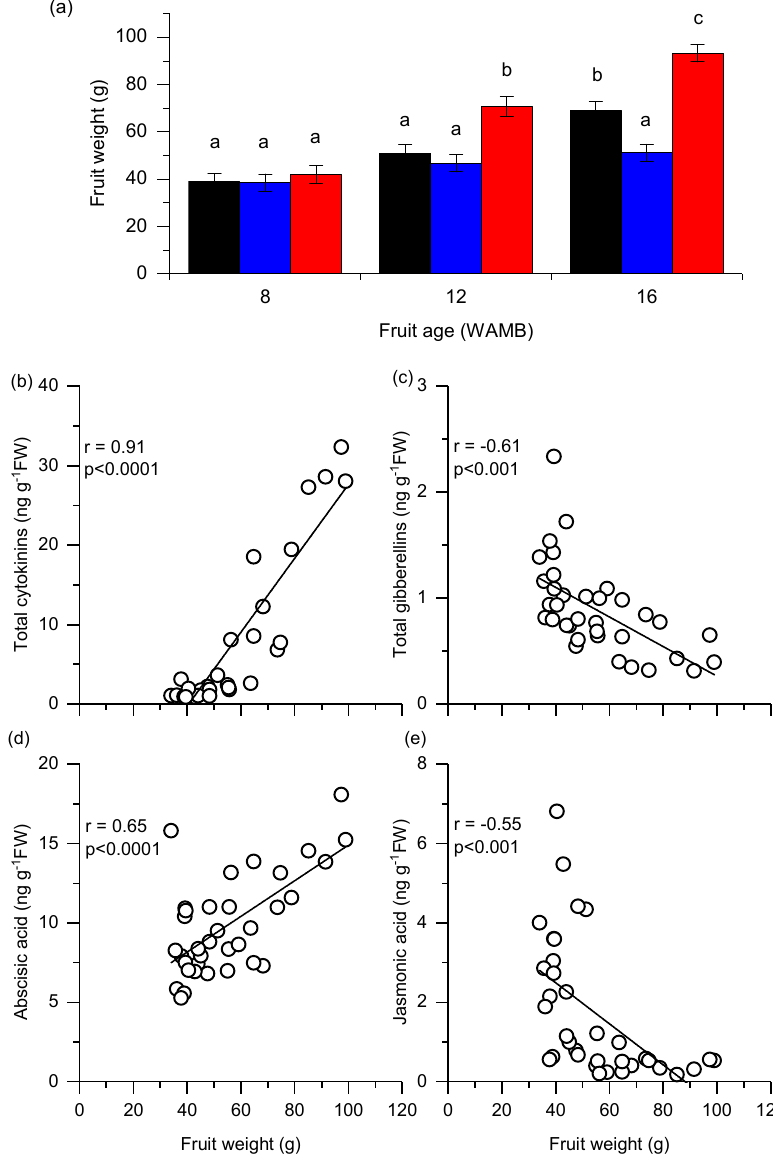
Figure 1. Fruit weight of kiwifruit ( a ) at three key stages of development: 8, 12, and 16 weeks after mid bloom (WAMB). Untreated control (black bar; vine standard), low carbohydrate supply (blue bar), and high carbohydrate supply (red bar). Values are averages ± SEM ( n = 3 or 4). Statistical analysis by linear mixed effects model with type 3 sums of squares Kenward–Roger’s method; different letters mean a statistical difference, adjusted for multiple comparison by Tukey’s correction ( p < 0.05). Pearson correlation analysis of between fruit weight and ( b ) total cytokinins, ( c ) total gibberellins, ( d ) abscisic acid, and ( e ) jasmonic acid concentration in fruit outer pericarp. n = 33 for cytokinins and n = 35 for the other phytohormones. FW, fresh weight. Phytohormones from the following classes were quantified in kiwifruit tissues: cytokinins, gibberellins, auxins, jasmonates, salicylates, and abscisates.